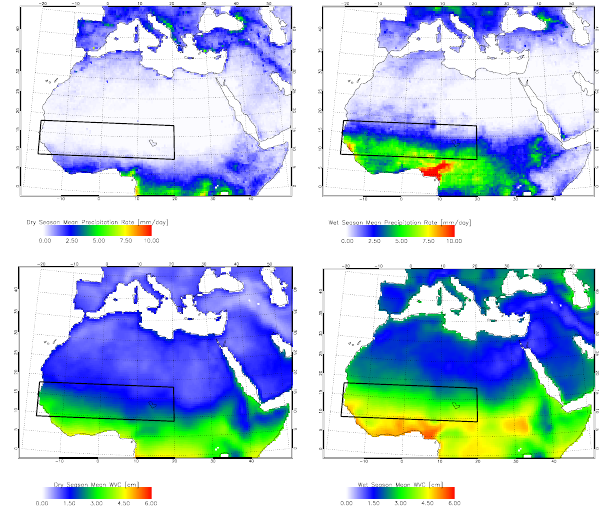
Fig. 1. Mean daily precipitation from TRMM observations 2004– 2008 (top line) and corresponding MODIS Water vapour Column (bottom line) in Northern Africa for the dry (left row) and wet (right row) seasons. The black boxes highlight the Sahel